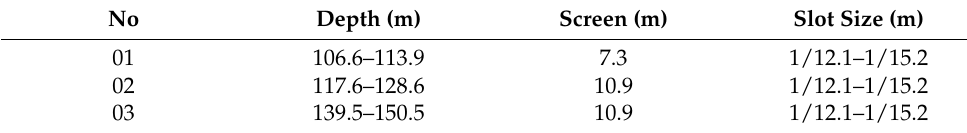
Figure 17. Spontaneous potential (SP), short normal resistivity (SNR), and long normal resistivity (LNR) log curves obtained in Well -1 of the experimental site of the Marwatan Banda, Karak. Table 7. The following screen schedule is proposed for conversion.